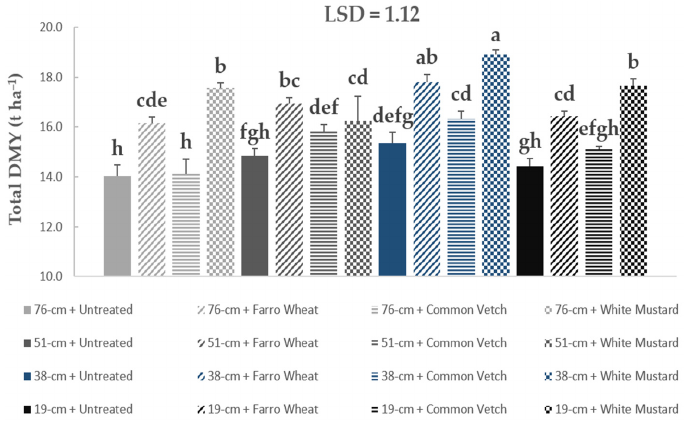
Figure 5. Sulla cumulative two-year total DMY (t ha − 1 ). Data refer to the significant row spacing by cover crop interaction observed in the second evaluation of sulla DMY (Eval 2). Different lowercase letters indicate significant differences. Vertical bars indicate standard errors. DMY; Dry Matter Yield.